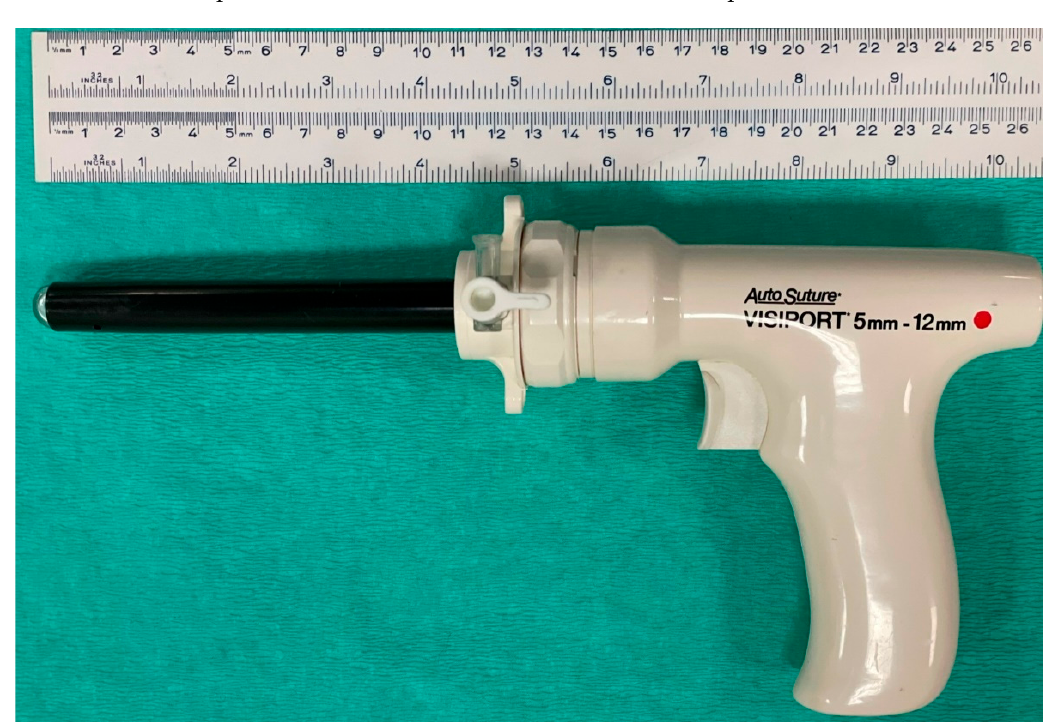
Figure 4. Device used in Group V. Disposable optic Visiport™ device inserted through a laparoscopic cannula (12 mm diameter, 11 cm length).